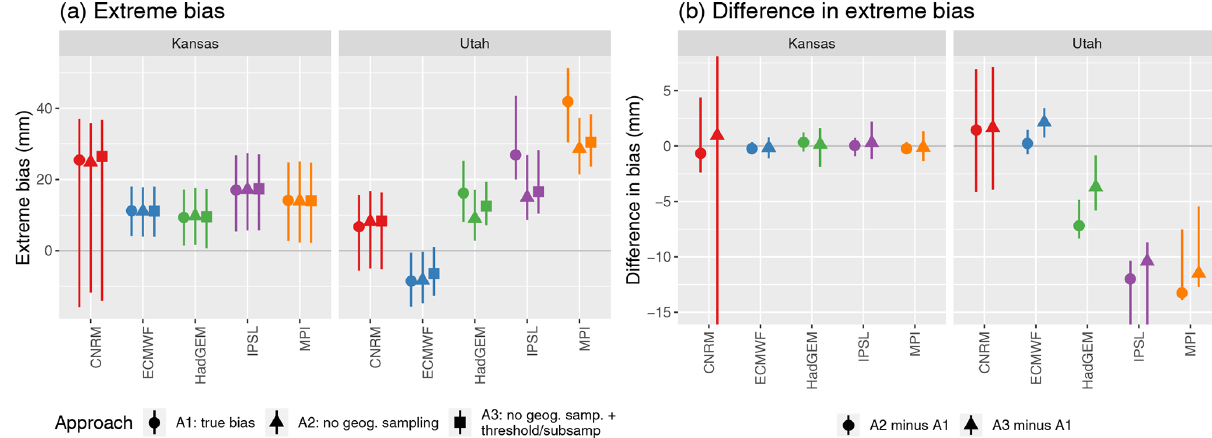
Figure 2. Extreme bias (difference in 20-year return values of Rx5Day) in Kansas and Utah for each model (model minus regridded L15) and approaches A1, A2, and A3 (a) , with the difference in extreme bias (in mm) for approach A2 (ignoring geographic sampling) versus A1 and approach A3 (assessing the effect of sampling density for Kansas and orography for Utah) versus A1 (b) . All estimates show the 90% basic bootstrap confidence